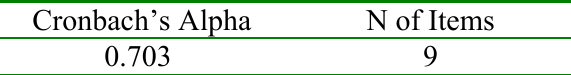
Reliability Statistics for the Reading Test ( N